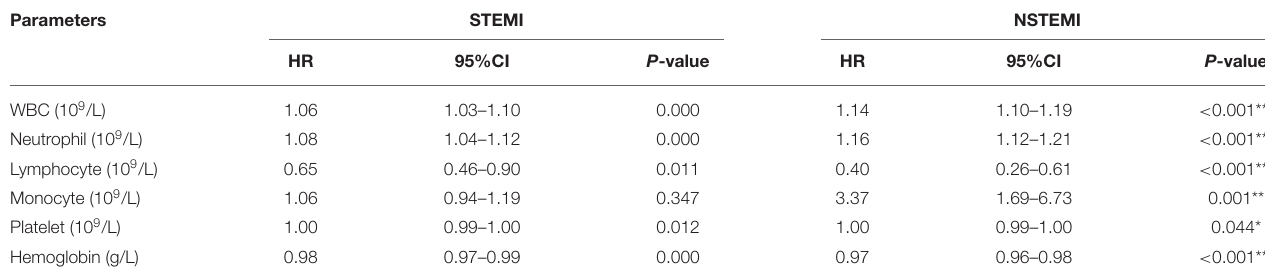
TABLE 2 | Univariate logistic regression of blood cell counts predicting in-hospital death in STEMI and NSTEMI patients.